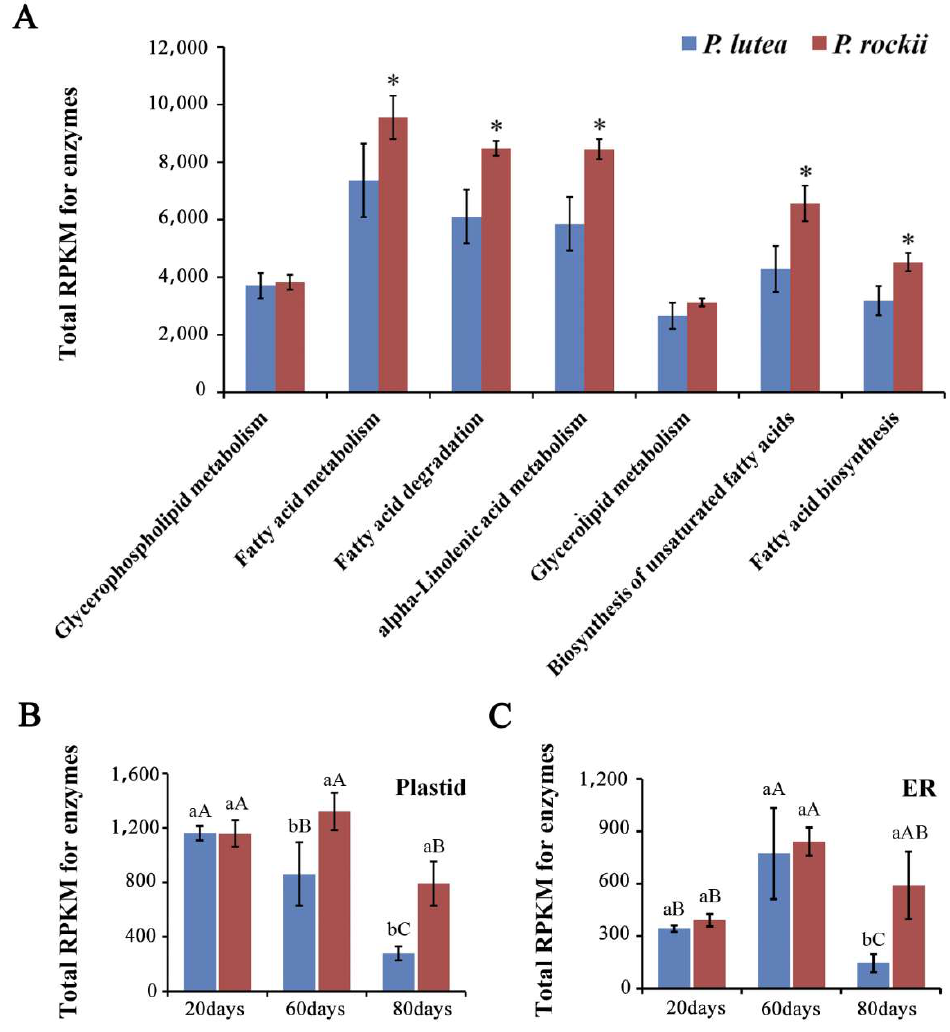
Figure 2. Transcriptome analyses of developing seeds of P. lutea and P. rockii . Total transcript levels for unigenes representing the ( A ) top seven lipid pathways (Table S2), ( B ) fatty acid synthesis in the plastid and ( C ) triacylglycerol assembly in the endoplasmic reticulum (ER; Table S4). RPKM: reads per kilobase per million. The asterisks indicate significant differences (* p < 0.05, Student’s t -test). Different small letters indicate significant differences between the species at the same time point at p < 0.05 level, as determined by the least significant differences test. Different capital letters indicate significant differences among different time points for the same